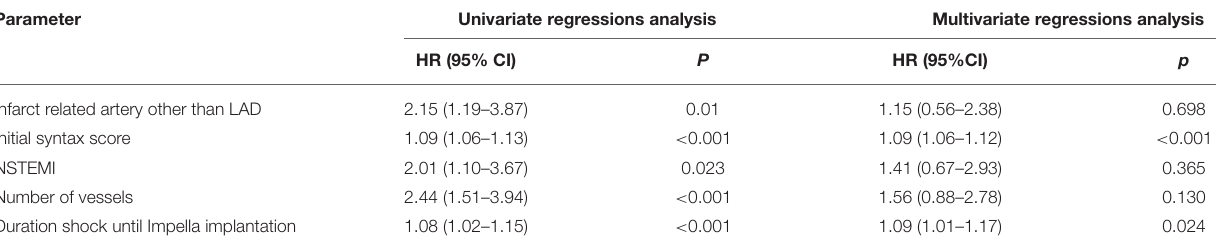
TABLE 3 | Uni- and multi-variate analysis of predictors for incomplete revascularisation. Parameter